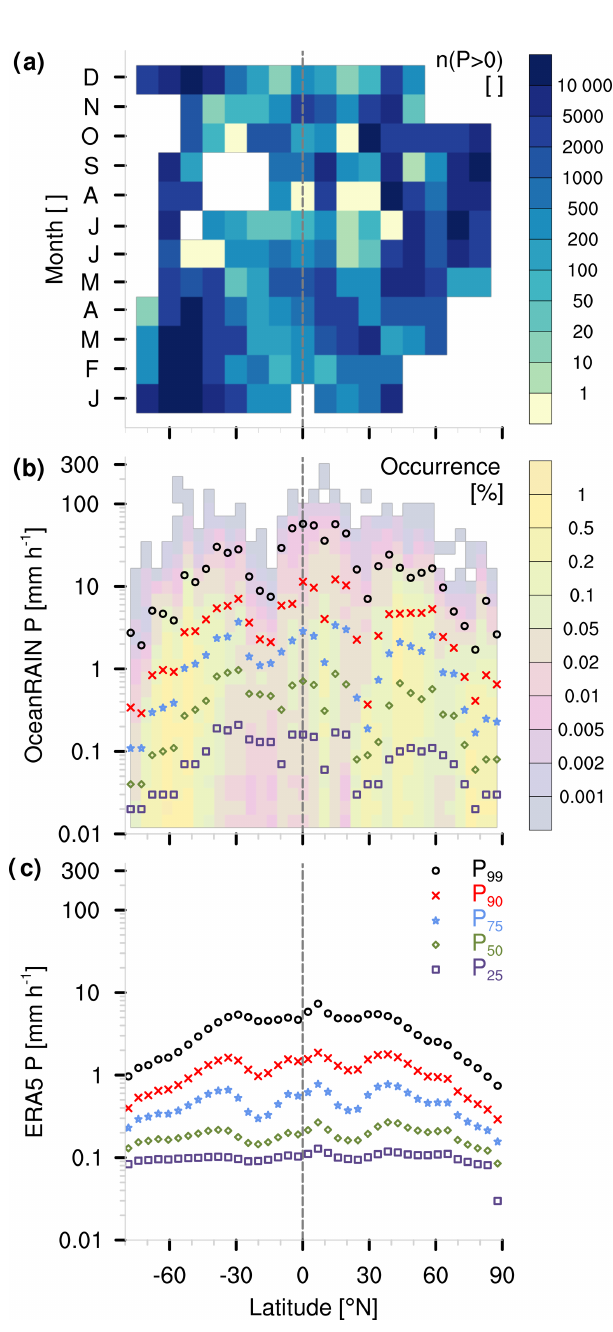
Figure 1. (a) Two-dimensional histogram of OceanRAIN (June 2010 to April 2017) precipitating minutes, n(P > 0 ) , per month as a function of latitude. Zero values (yellow boxes) indi- cate no precipitation sampling. White boxes indicate no sampling at all. (b) Five percentiles of OceanRAIN precipitation (mmh − 1 ) as a function of 1 ◦ latitude bands with relative occurrence (%) shown in color. (c) As with (b) but for ERA5 (June 2010 to December 2016).